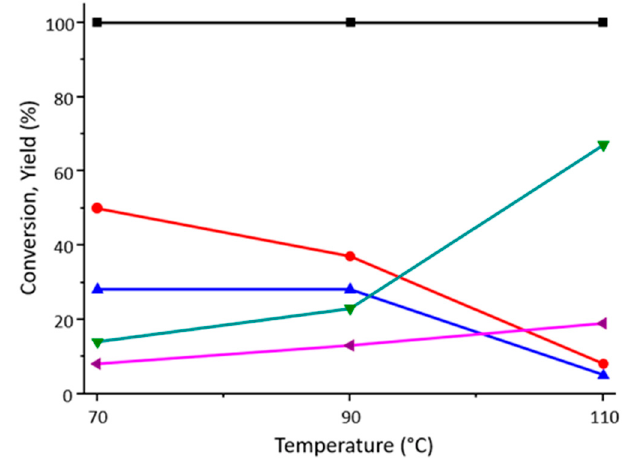
Figure 4. Reaction temperature effect on the catalytic performance of NYL + TiO 2 + AuPd sample. Operative conditions: 4 h, O 2 pressure 10 bar, 25 mL water, HMF concentration 0.018 M, HMF:NaOH molar ratio 1:2, HMF:(Au + Pd) molar ratio 100:1. Legend: ■ HMF Conversion, • HMFCA yield, ▲ FFCA yield, ▼ FDCA yield, ◄ C-LOSS.